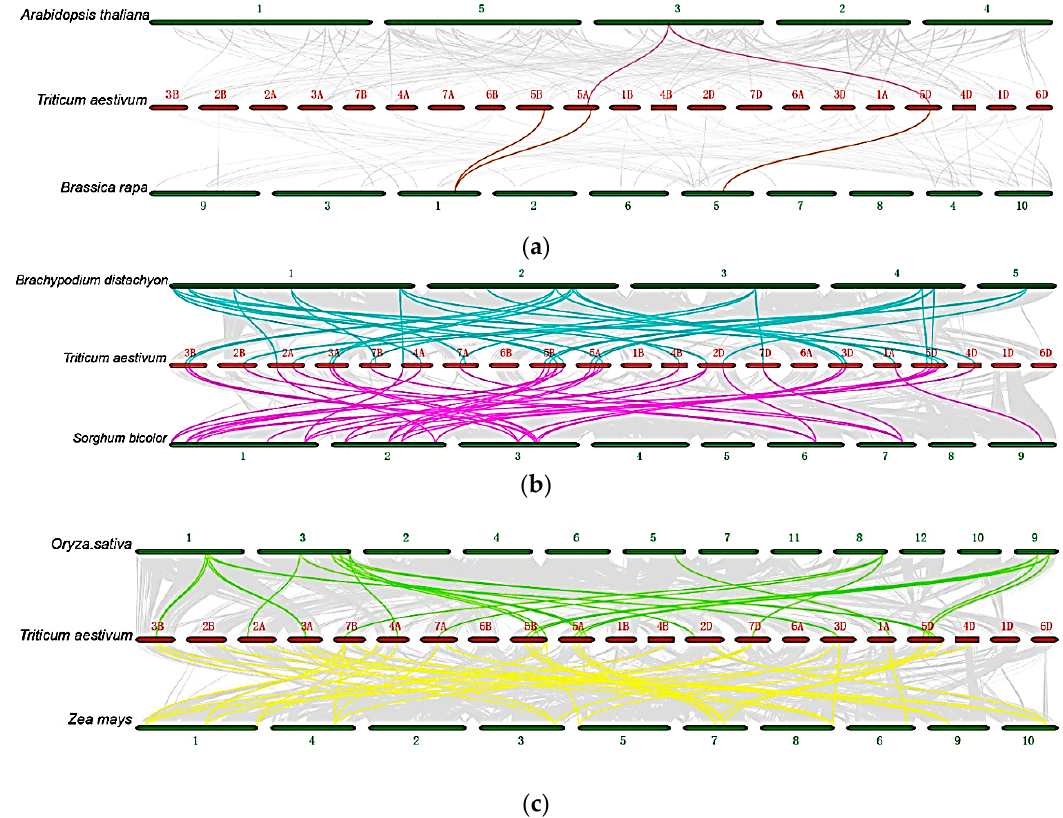
Figure 1. Synteny relationships of Hsfs in wheat and six representative species. ( a ) Synteny relationships of Hsfs between wheat with Arabidopsis ( Arabidopsis thaliana ) and Chinese cabbage ( Brassica rapa ). ( b ) Synteny relationships of Hsfs between wheat with rice ( Oryza sativa ) and maize ( Zea mays ). ( c ) Synteny relationships of Hsfs between wheat with sorghum ( Sorghum bicolor ) and Brachypodium ( Brachypodium distachyon ). Gray lines in the background indicate the synteny blocks for wheat and other plant genomes, and the lines in other colors highlight the synteny of Hsf pairs.